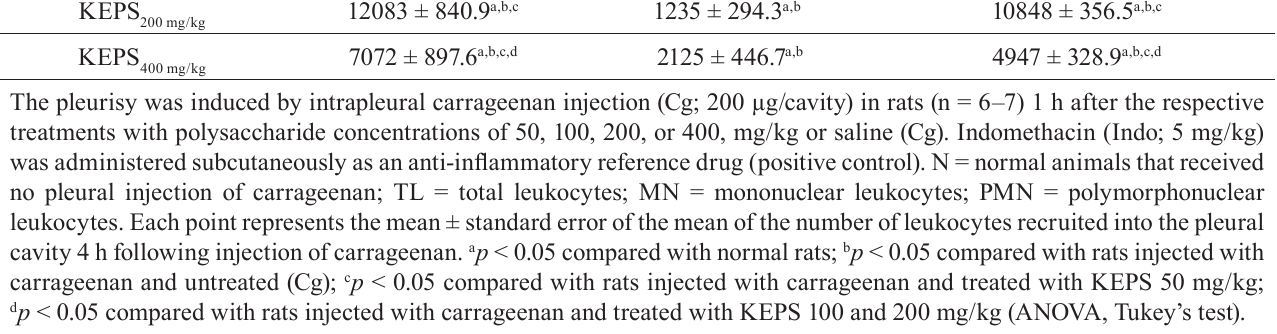
TABLE IV - KEPS effect on the number of total and differential leukocytes in pleural inflammatory exudate of rats Cells/mm 3 Groups of animals TL PMN MN KEPS 12083 ± 840.9 a,b,c 1235 ± 294.3 a,b 10848 ± 356.5 a,b,c 200 mg/kg KEPS 7072 ± 897.6 a,b,c,d 2125 ± 446.7 a,b 4947 ± 328.9 a,b,c,d 400 mg/kg The pleurisy was induced by intrapleural carrageenan injection (Cg; 200 µg/cavity) in rats (n = 6–7) 1 h after the